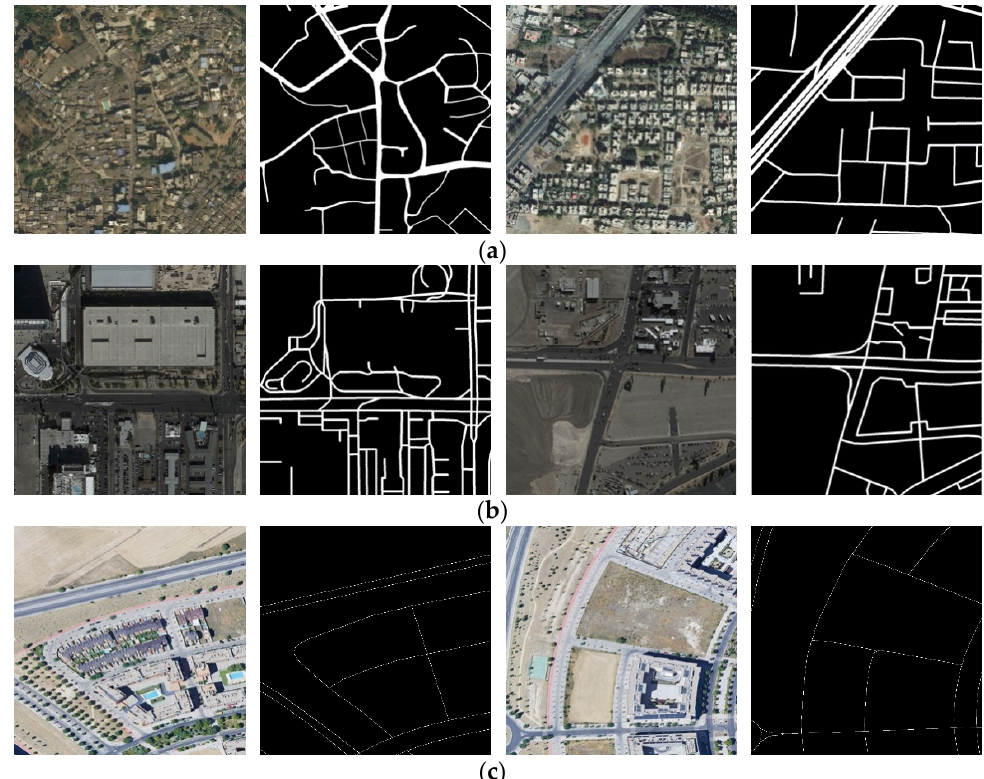
Figure 6. Visualization of the three experimental datasets: ( a ) DeepGlobe dataset; ( b ) RoadTracer dataset; ( c ) Google dataset.